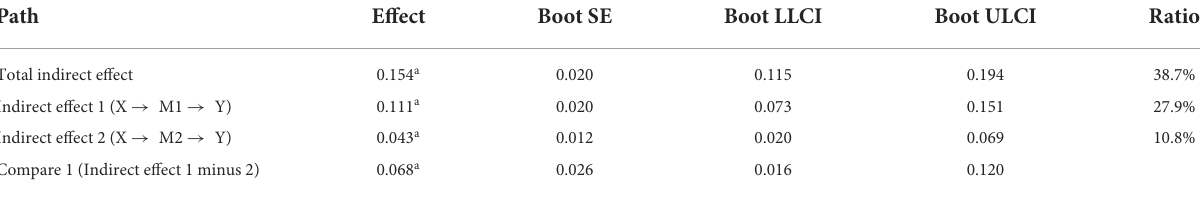
TABLE 5 The results of the multiple mediation model.